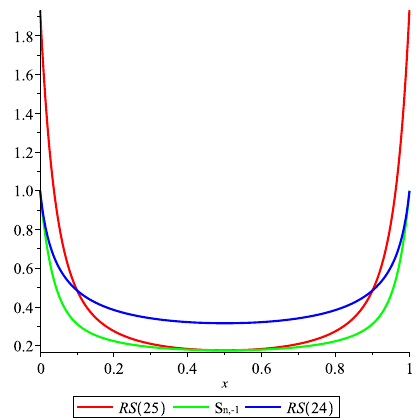
Figure 3. Graphs of upper bounds of S n , − 1